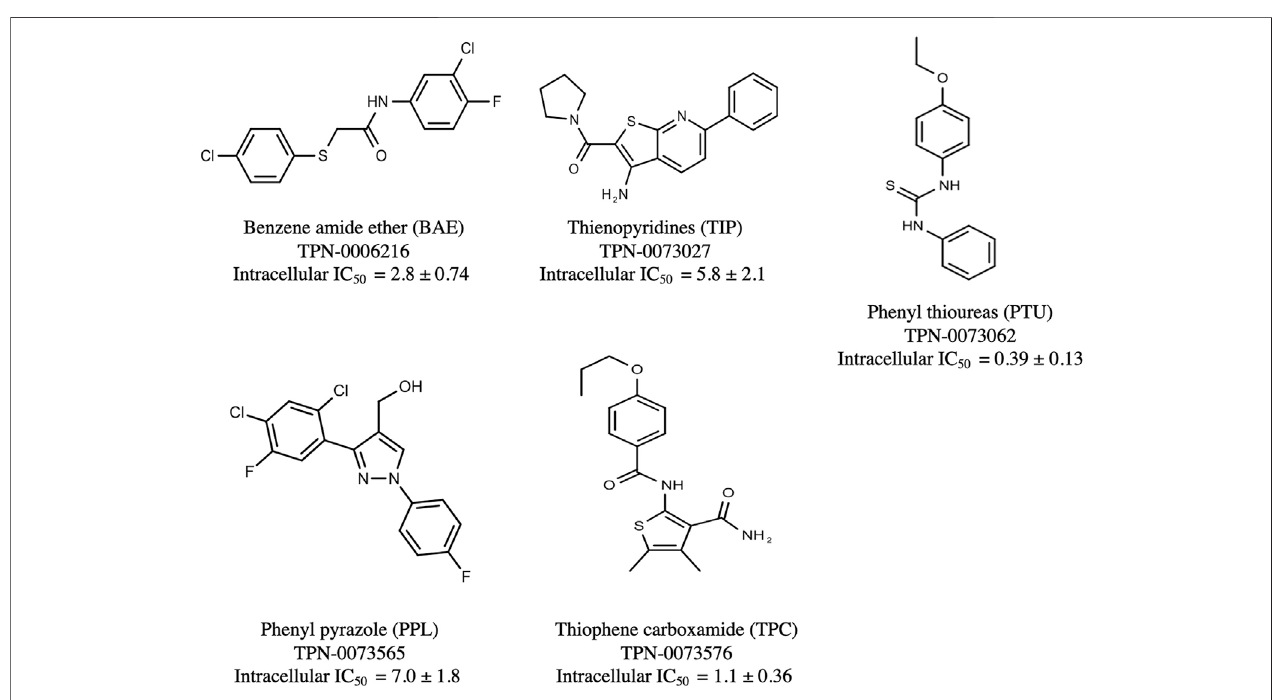
FIGURE 4 | Representative molecules from selected